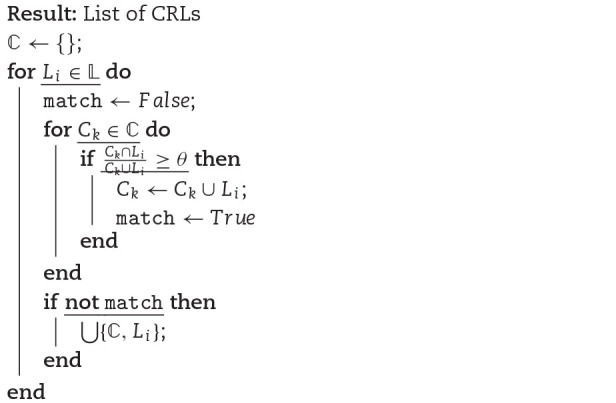
CRL creation from expressed loci. \documentclass[12pt]{minimal}
\usepackage{amsmath}
\usepackage{wasysym}
\usepackage{amsfonts}
\usepackage{amssymb}
\usepackage{amsbsy}
\usepackage{upgreek}
\usepackage{mathrsfs}
\setlength{\oddsidemargin}{-69pt}
\begin{document}
}{}$\mathbb{C}$\end{document} is the list of CRLs; \documentclass[12pt]{minimal}
\usepackage{amsmath}
\usepackage{wasysym}
\usepackage{amsfonts}
\usepackage{amssymb}
\usepackage{amsbsy}
\usepackage{upgreek}
\usepackage{mathrsfs}
\setlength{\oddsidemargin}{-69pt}
\begin{document}
}{}$\mathbb{L}$\end{document} is the list of expressed loci; \documentclass[12pt]{minimal}
\usepackage{amsmath}
\usepackage{wasysym}
\usepackage{amsfonts}
\usepackage{amssymb}
\usepackage{amsbsy}
\usepackage{upgreek}
\usepackage{mathrsfs}
\setlength{\oddsidemargin}{-69pt}
\begin{document}
}{}$L_i$\end{document} is the set of read segments of an expressed locus i and \documentclass[12pt]{minimal}
\usepackage{amsmath}
\usepackage{wasysym}
\usepackage{amsfonts}
\usepackage{amssymb}
\usepackage{amsbsy}
\usepackage{upgreek}
\usepackage{mathrsfs}
\setlength{\oddsidemargin}{-69pt}
\begin{document}
}{}$C_k$\end{document} is the set of read segments of a CRL k.